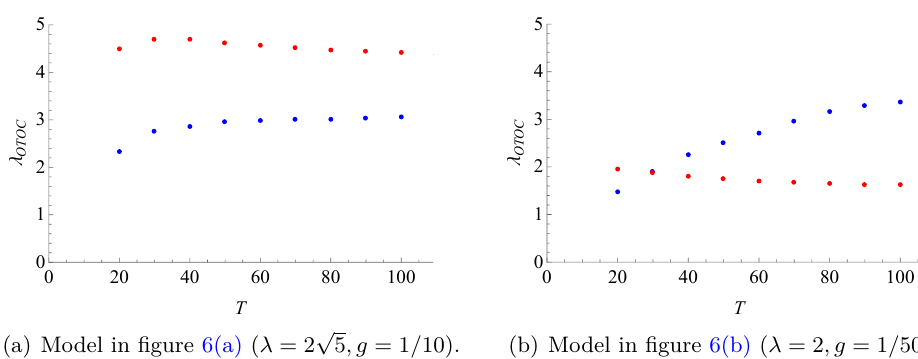
(b) Model in figure 6(b) ( λ = 2 , g = 1 / 50) Figure 9 . Quantum Lyapunov exponent vs temperature. Red dots: soft-wall, Blue dots: